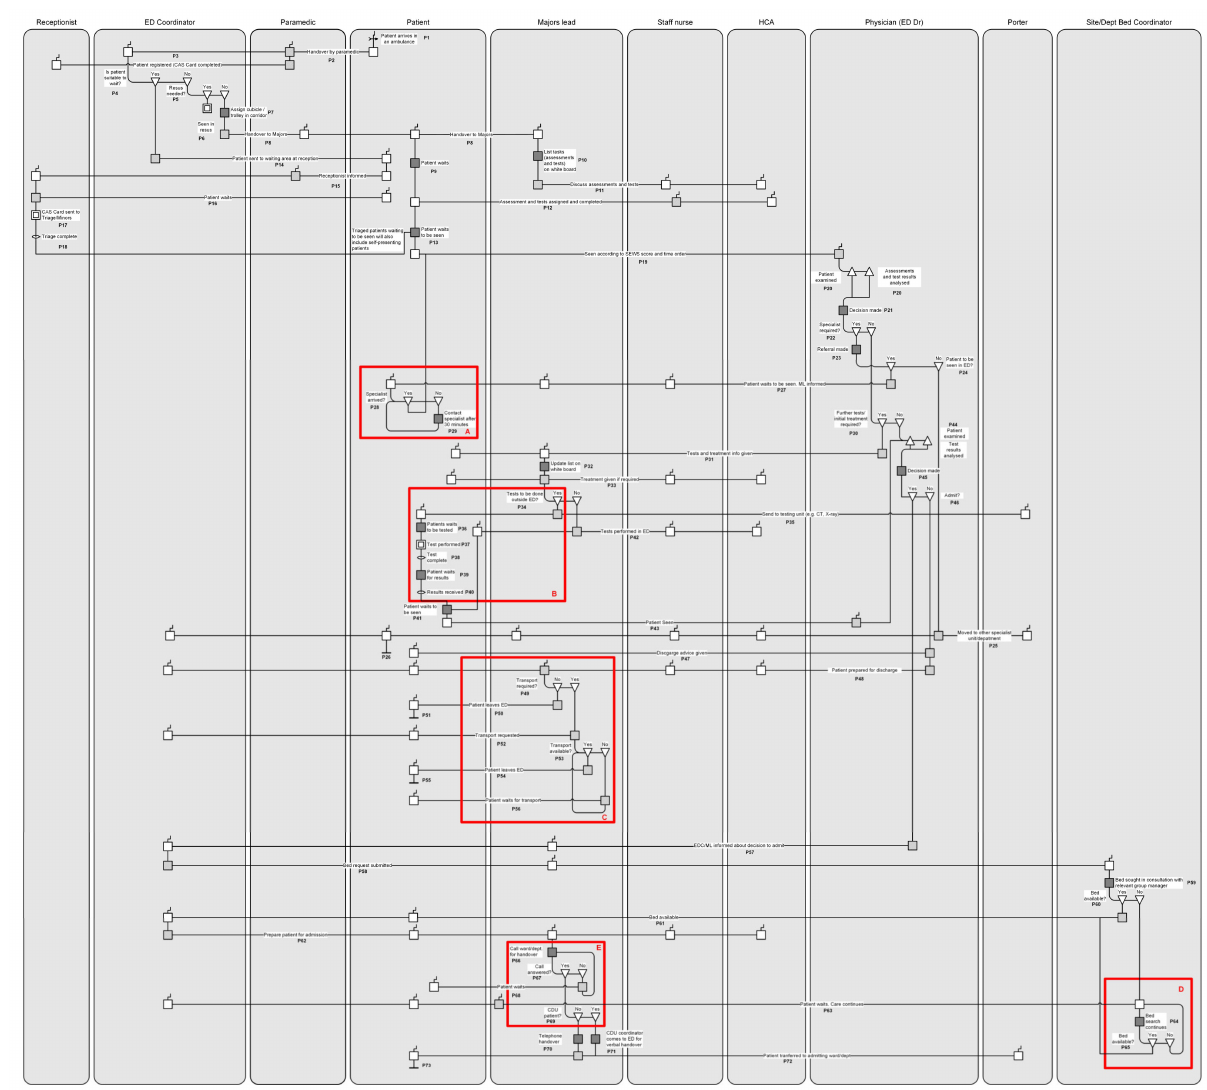
Figure 2. RAD of a patient’s journey through the Majors unit. Note: Phys: Physician; SEWS: Standardised Early Warning Score; CT: Computerised Tomography, CDU: Clinical Decision